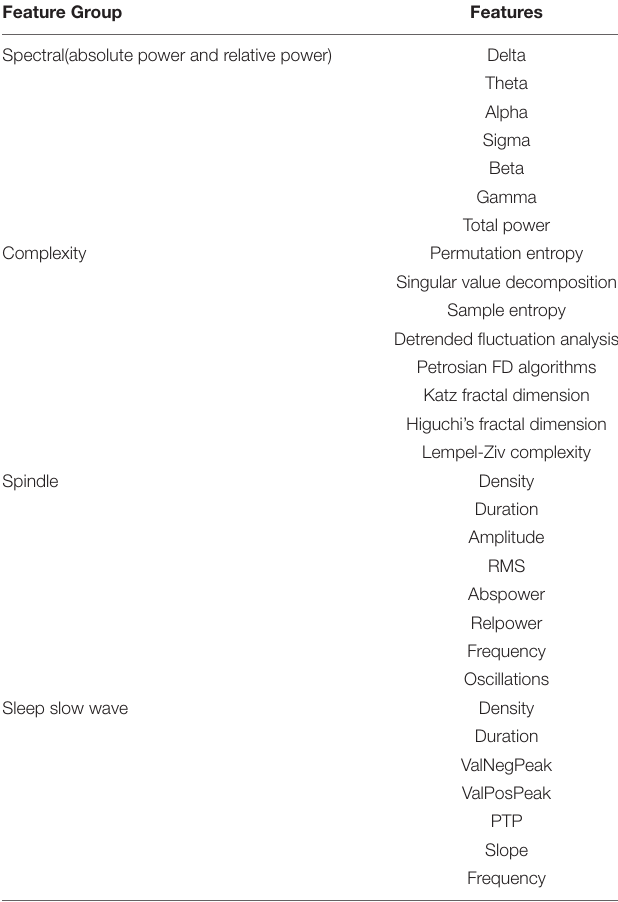
TABLE 2 | List of computed features for each 5-min segment. Feature Group